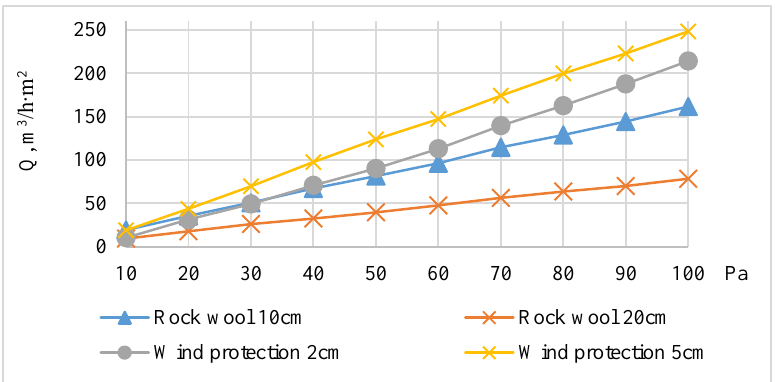
Figure 4. The measured air permeability of different types of rock wool thermal insulation and wind protection boards.